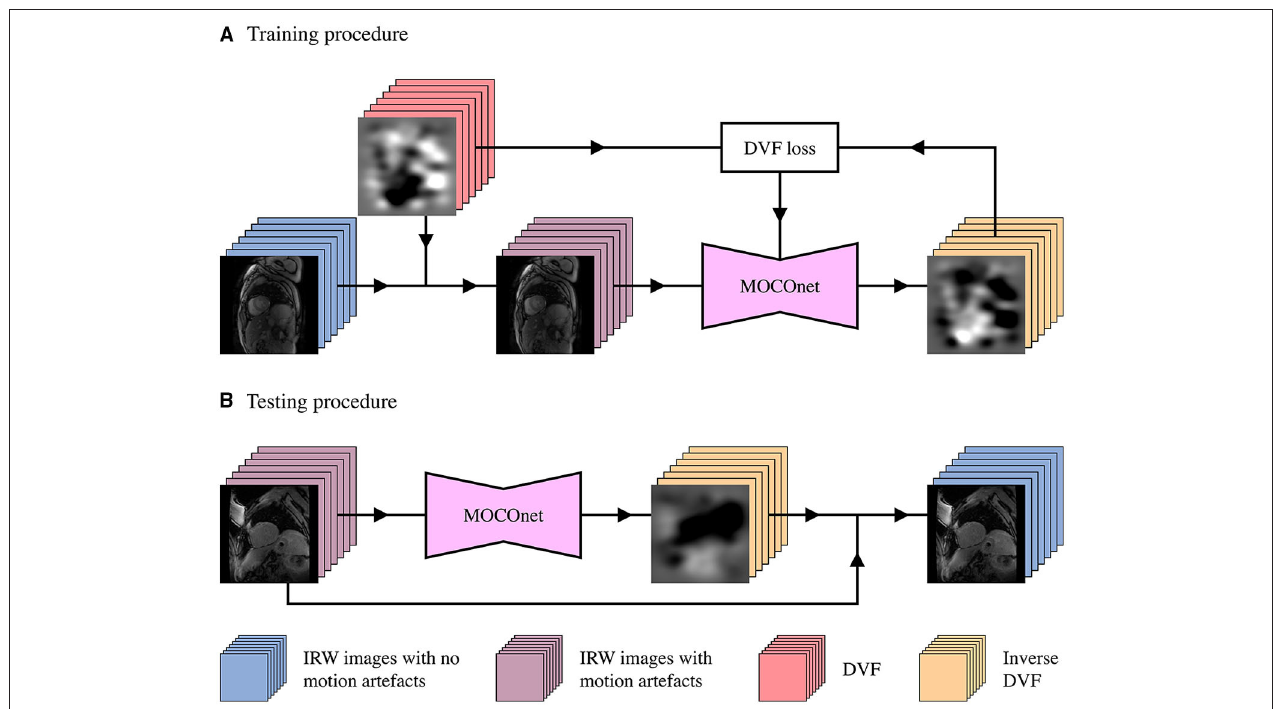
FIGURE 3 | Development workflow of the proposed motion correction convolutional neural network (MOCOnet) for myocardial ShMOLLI T1 mapping. (A) MOCOnet was trained on 1,536 sets of seven inversion recovery-weighted (IRW) images with no motion artefacts which were synthetically deformed with displacement vector fields (DVFs), to predict the inverse DVF required to correct the motion. (B) MOCOnet was tested on 200 T1 maps with a varied degree of motion artefacts. Each stack denotes a set of seven images; each junction denotes the DVFs application to the IRW images; the box with DVF loss represents the weight adjustment during